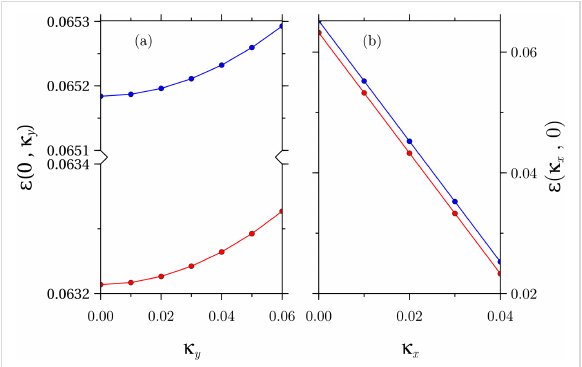
Figure 6: First Landau level dispersions for b = 0.5 and f =0.499. In panel (a), the original parabolic dispersion along the y -direction splits into two parabolic dispersions with energies below the band edge for the chosen fields, whereas in panel (b), the previously obtained split- ting in the x -direction is now exclusively